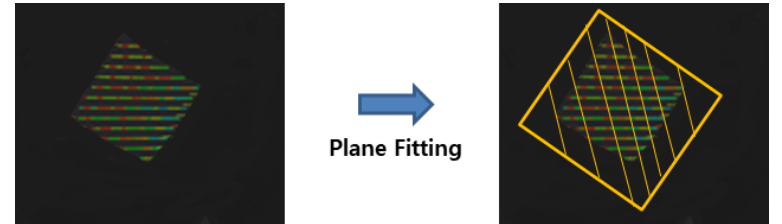
Figure 11. 3D Plane Fitting.